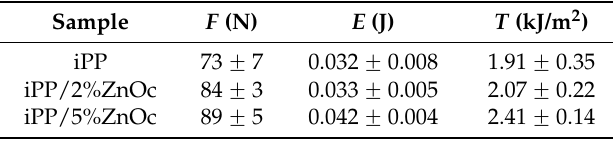
Table 4. Impact tests values for iPP and iPP/ZnOc composites.